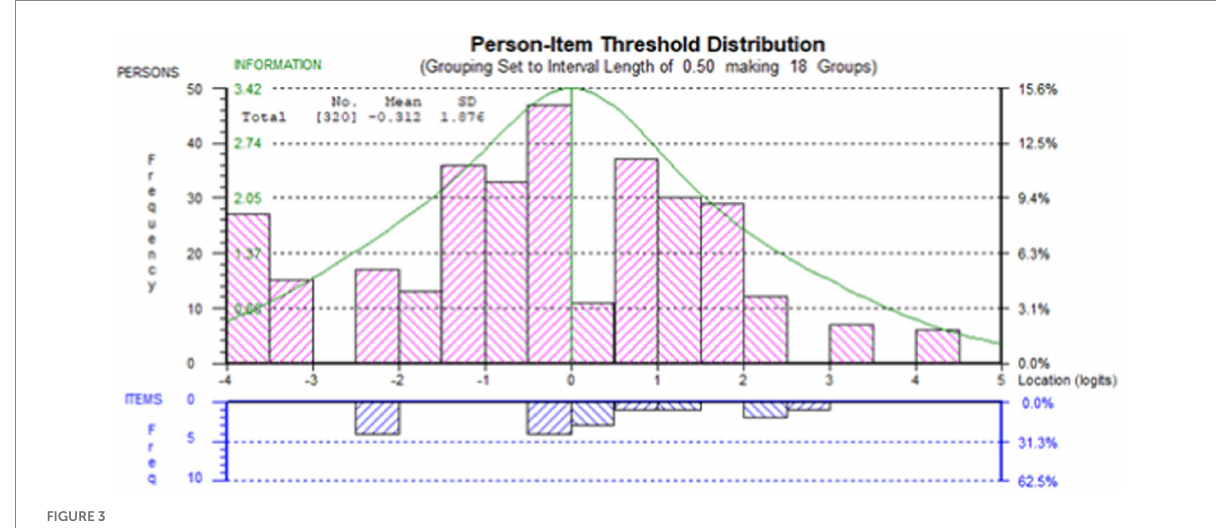
FIGURE 3 Person-item threshold